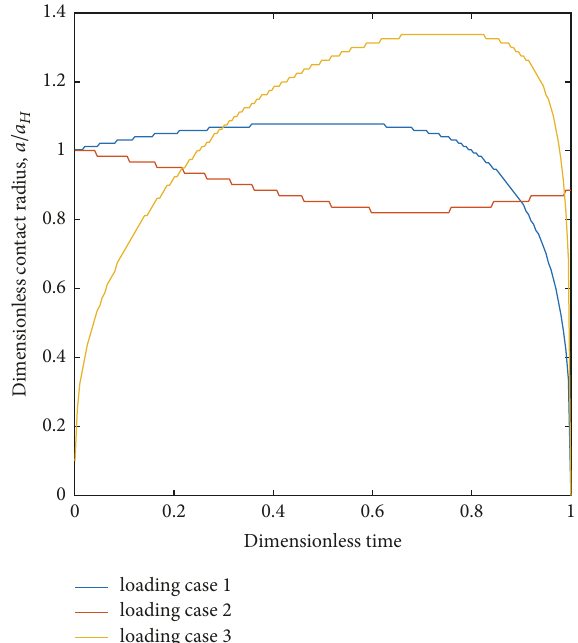
Figure 6: Evolution of contact radius in the indentation of a Maxwell half-space under specific loading